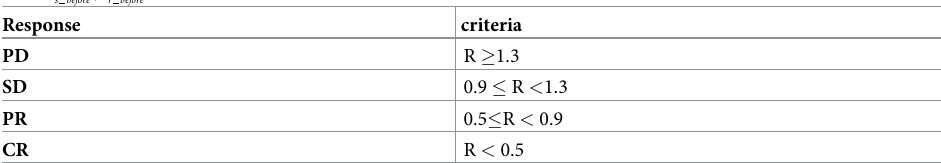
Table 1. Response criteria for virtual patients (VPs). R is the ratio of tumor burden before and after the treatment ( R ¼ X s after þ X r after X s before þ X r before